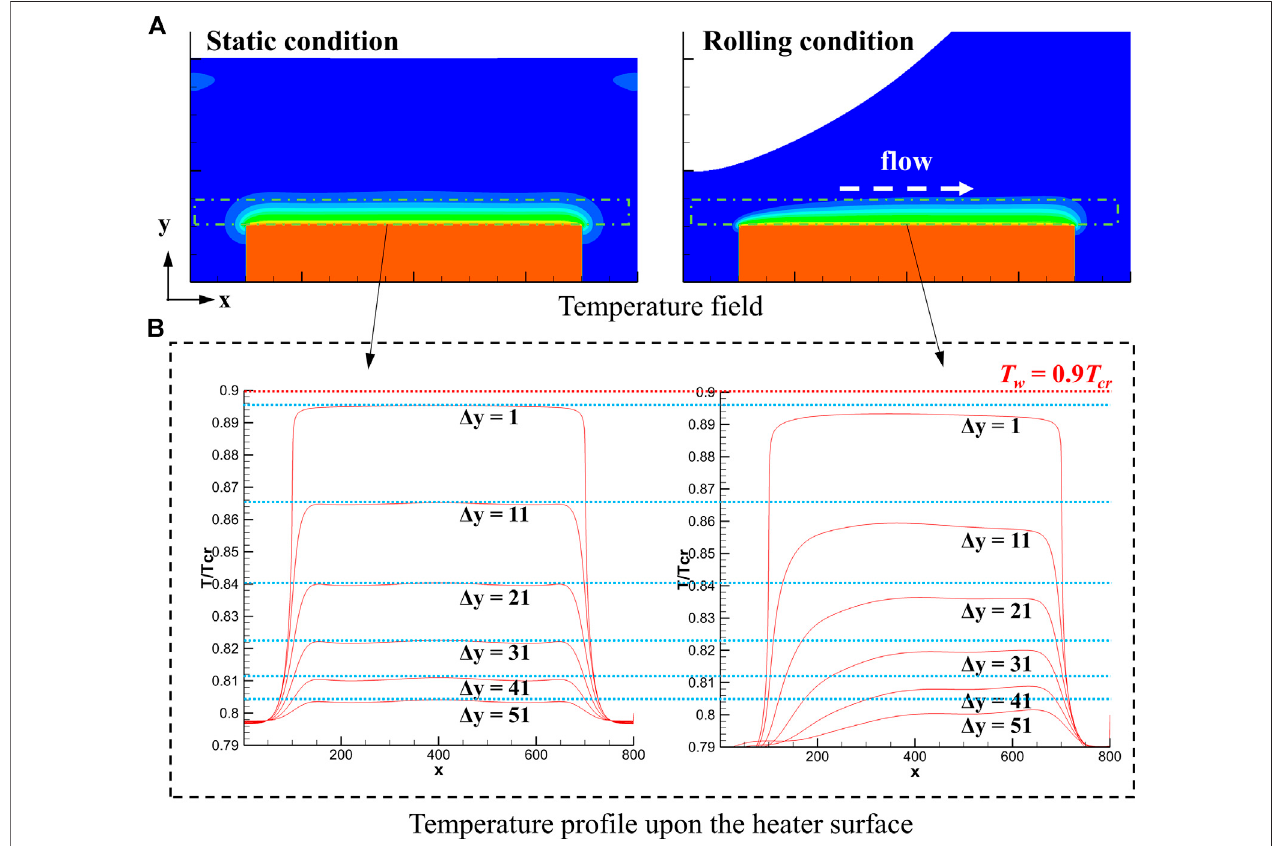
FIGURE5| Analysisofheattransferatconvectionregionunderbothstaticandrollingconditions: (A) temperature fi eld, (B) temperaturepro fi leupontheheaterwith Δ y (cid:1) y - y heater representing the distance from heater surface.